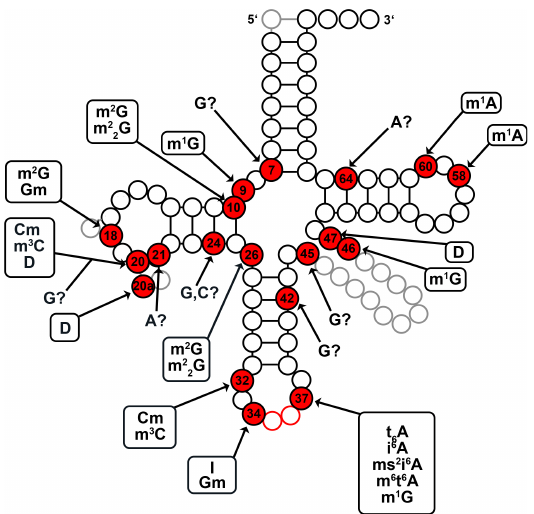
Figure 2. Modification pattern of Dictyostelium discoideum tRNAs. All tRNA positions showing accumulations of base misincorporations and/or RTa sites are highlighted in red. Modifications that matched to known tRNA modifications of other species from the tRNAmodviz database [3] are highlighted at the individual tRNA positions. Modifications, for which no clear classifica- tion is possible based on unambiguous RT signatures and no information is available from other species, are marked with a question mark next to the affected nucleotide. The tRNA positions are numbered according to Sprinzl et al. [54]). Abbreviations: A–adenosine; C–cytidine; Cm–2 (cid:48) − O